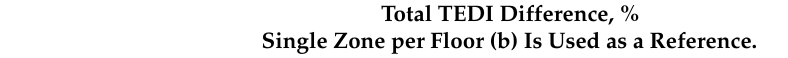
Table 1. Change in the total thermal energy demand intensity (TEDI) due to different zoning approaches (Figure 11) at the district